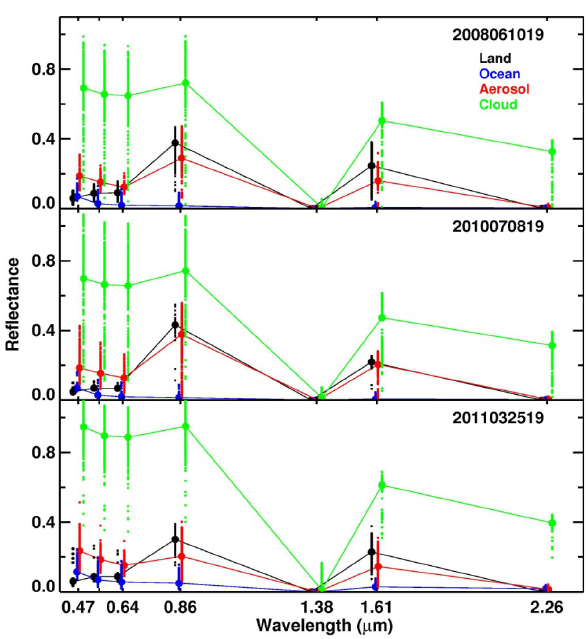
Figure 4 Fig. 4. Spectral signatures of land, ocean, aerosol, and cloud for 10 June 2008 (top), 8 July 2010 (middle), and 25 March 2011 (bot- tom). The spectral signatures for the imaginary green band are also shown between the blue and red